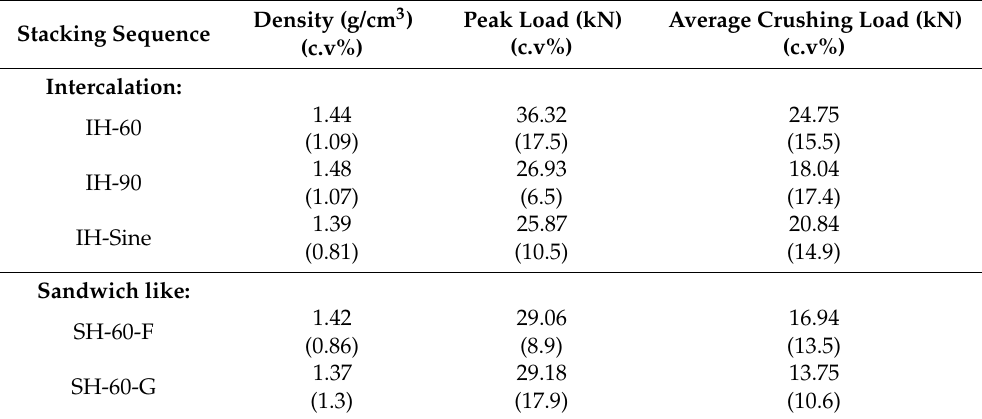
Table 3. Average results of the axial crushing test of each